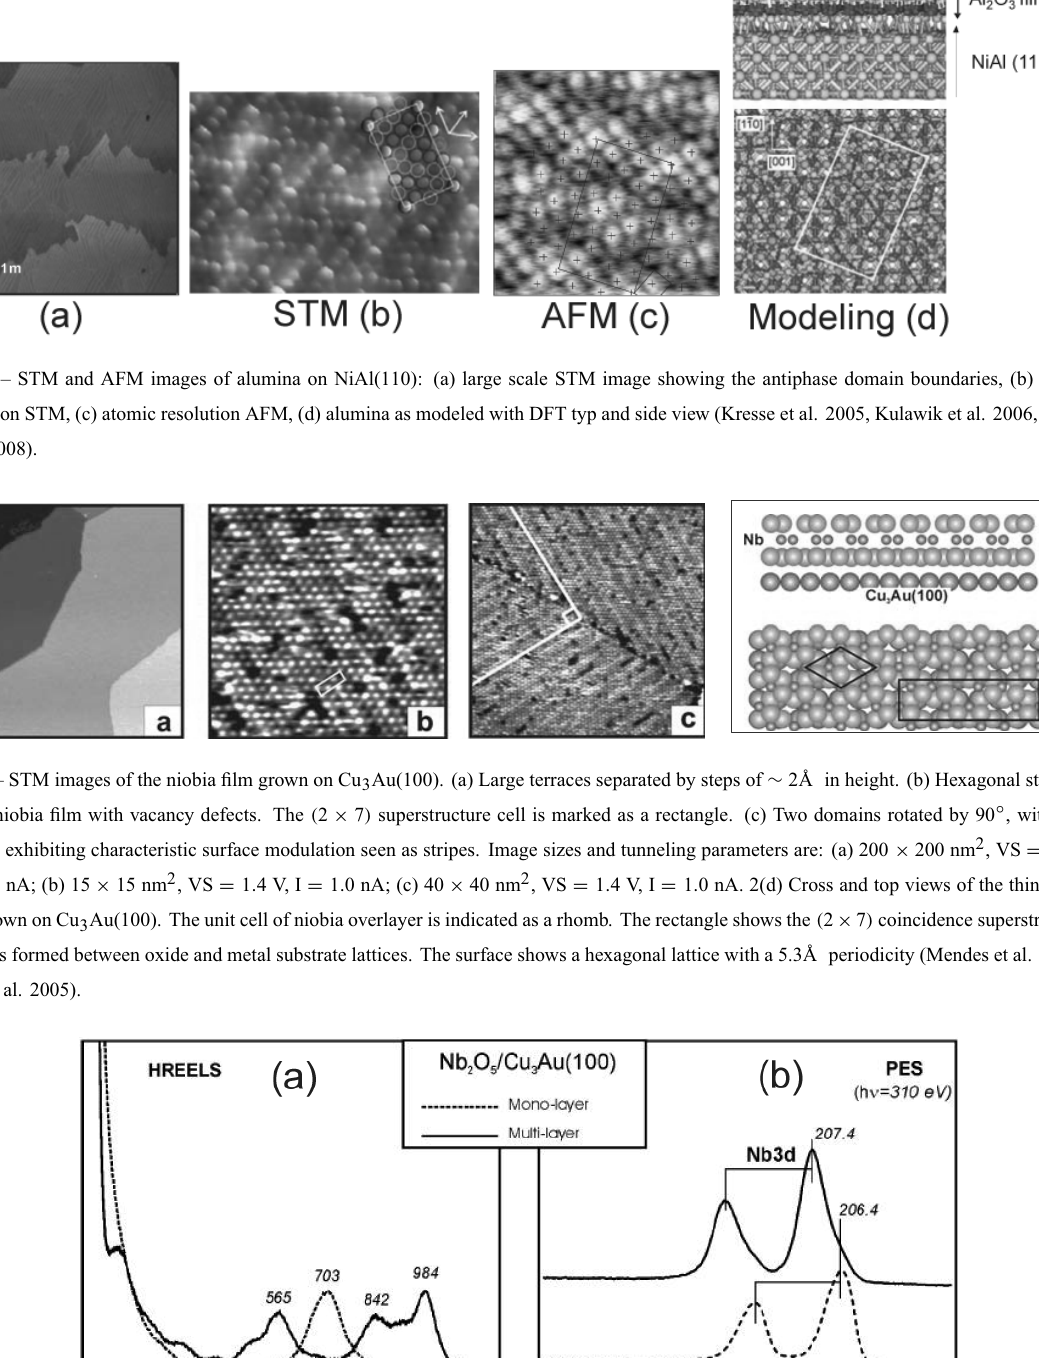
Fig. 9 – HREEL-spectra measured in specular geometry, and PES spectra measured at normal electron emission for monolayer and multilayer niobia films grown on Cu 3 Au(100) (see the text) (Uhl et al. 2007).